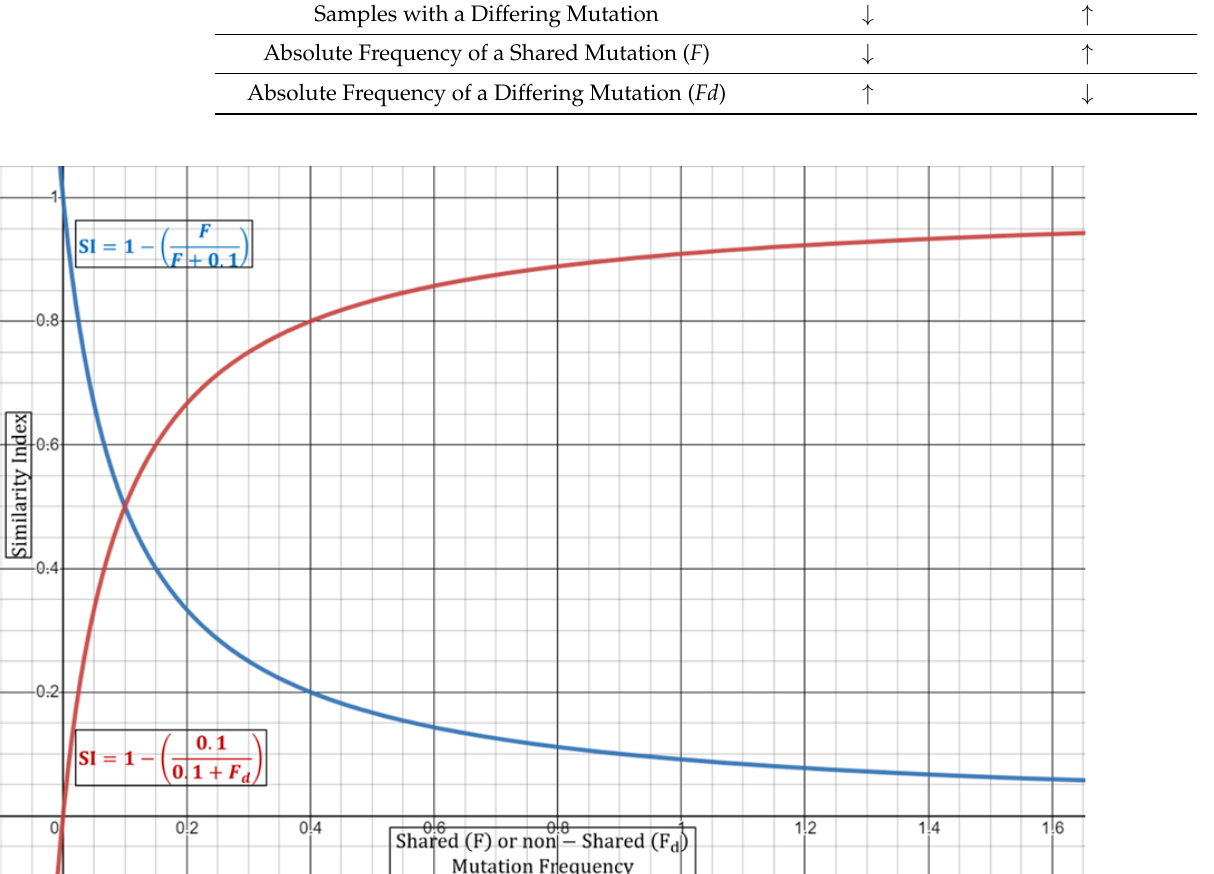
Table 2. Effects on Similarity Index Outcome (Equation (3)) ↑ / ↓ .